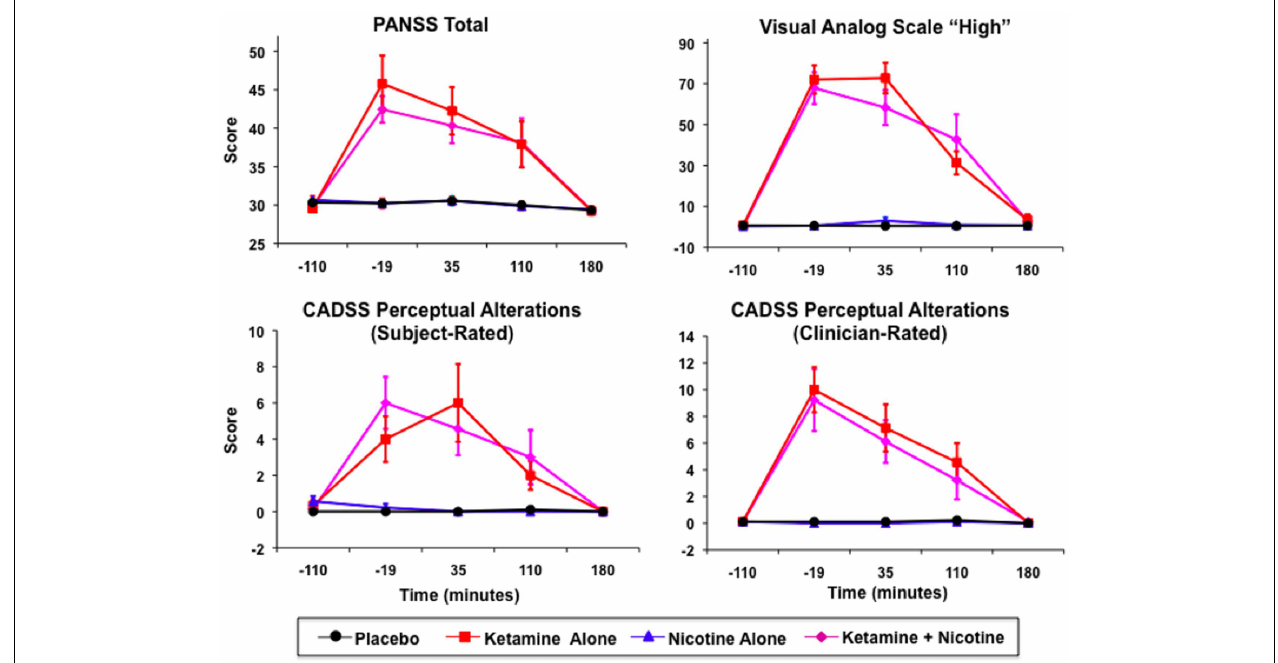
FIGURE 2 | Mean and standard errors are plotted for Positive and Negative Syndrome Scale (PANSS) total scores (upper left),Visual Analog Scale of subjective states (upper right), subject-rate (lower-left) and clinician-rated (lower-right) perceptual alterations using the